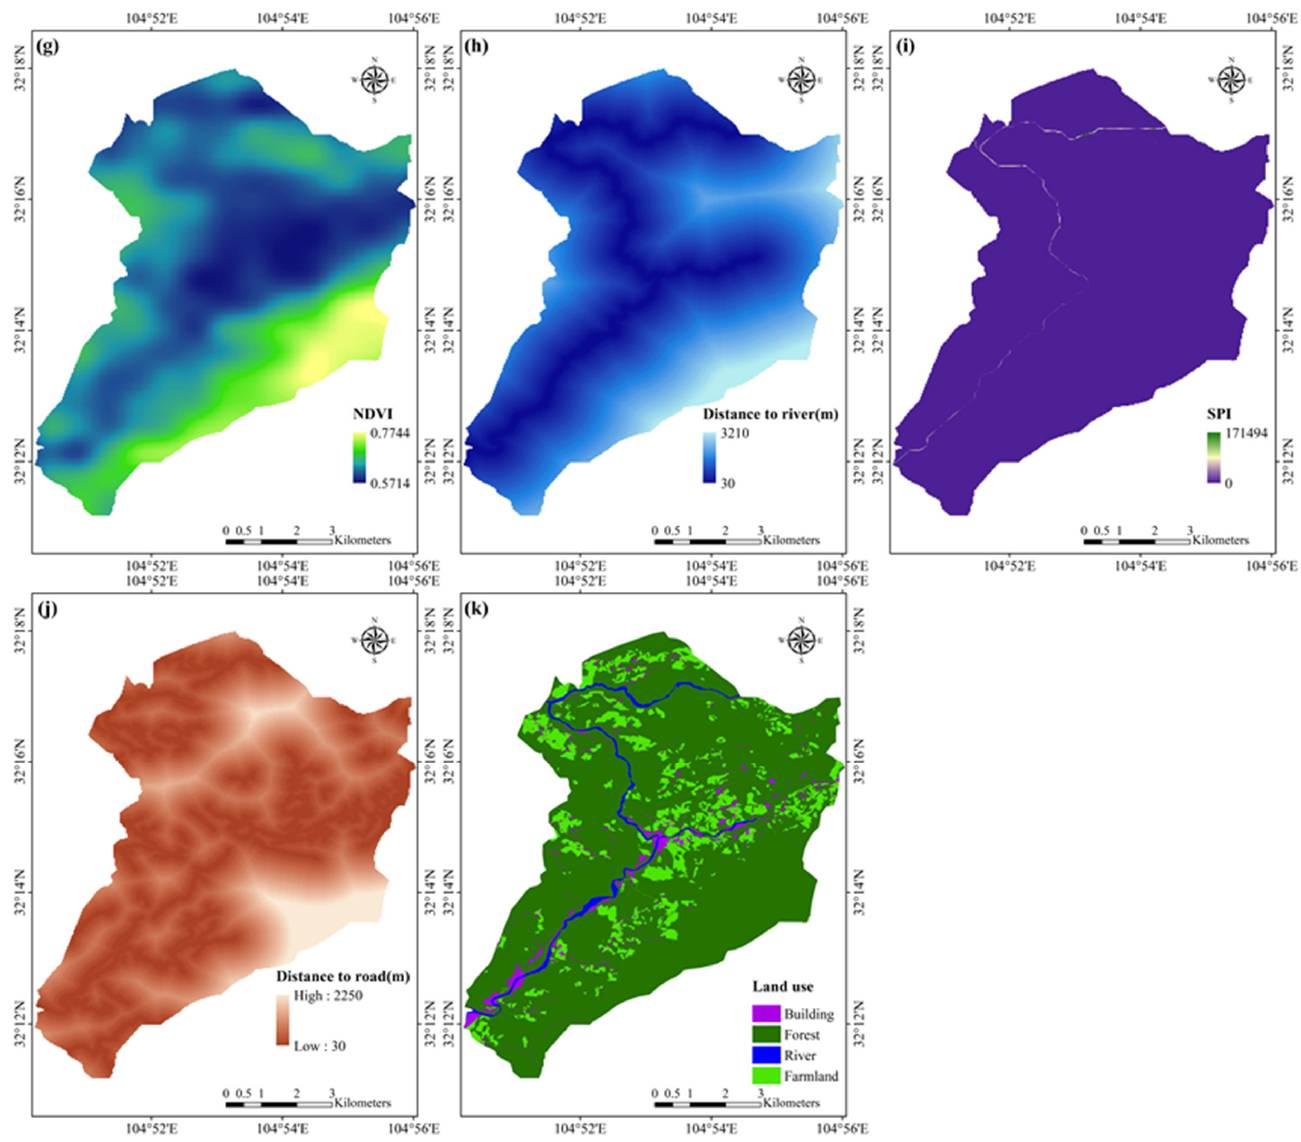
Figure 2. Conditioning factors maps: ( a ) lithology, ( b ) elevation, ( c ) slope angle, ( d ) slope aspect, ( e ) surface roughness, ( f ) total curvature, ( g ) NDVI, ( h ) distance to river, ( i ) SPI, ( j ) distance to road, ( k ) land use.